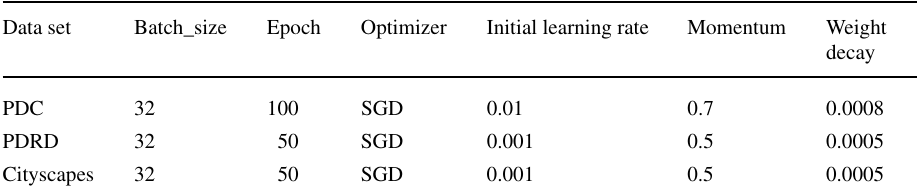
Table 1 Hyperparameter settings for the learning phase of the proposed model on the three data sets